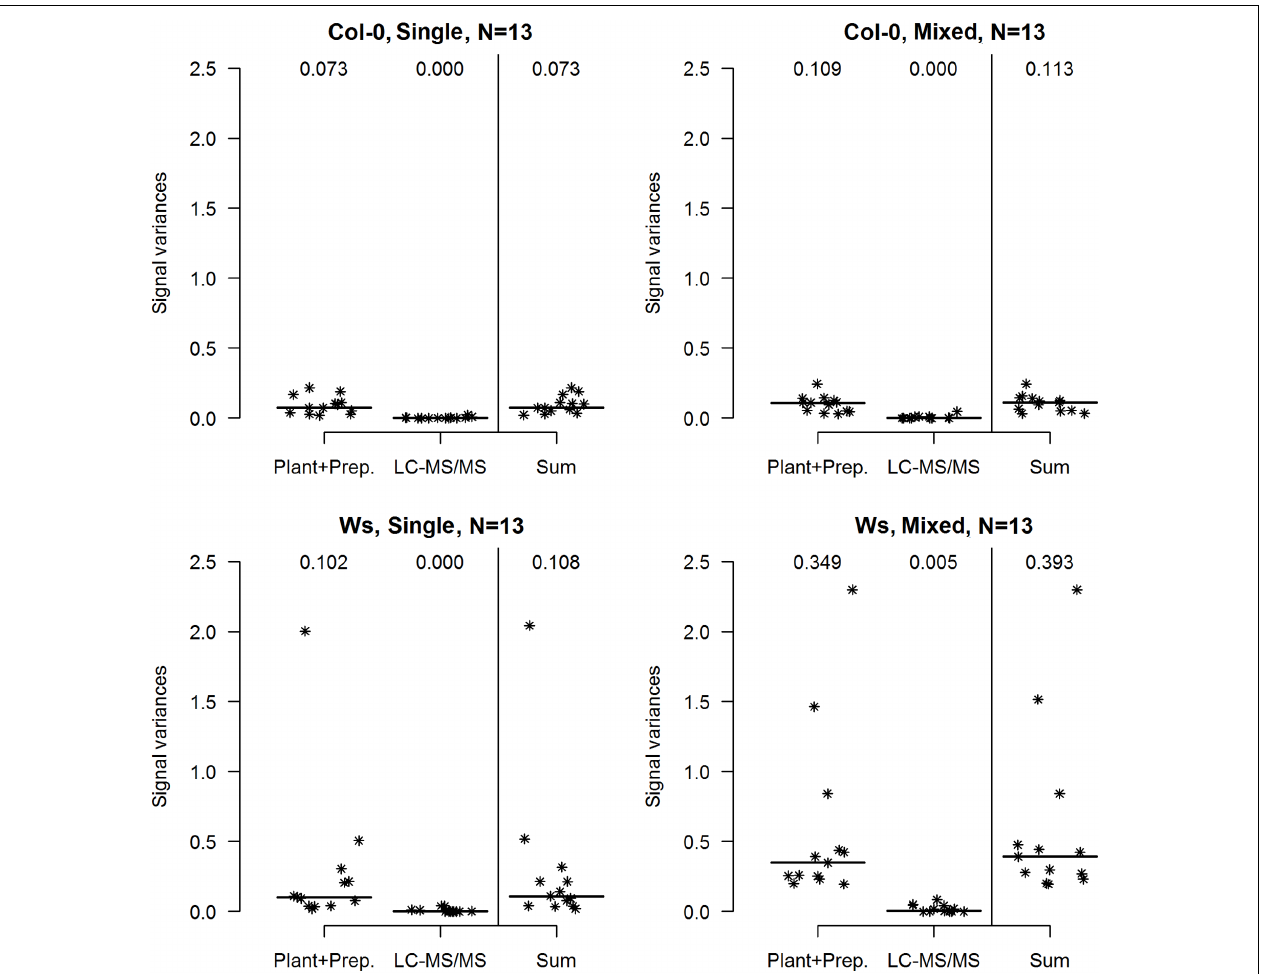
FIGURE 2 | Contributions of biological and technical components to the total variance of observed histone mark levels in A. thaliana Col-0 and Ws ecotypes grown from seeds collected from a single parent plant (Single) and a set of parent plants (Mixed). In each case, the total variance (Sum) of the abundance of selected individual H3 and H4 histone peptide forms ( N = 13) was decomposed into variance related to plant cultivation and sample preparation (biological, denoted Plant + Prep.) and variance related to measurement by the LC-MS/MS system (technical, denoted LC-MS/MS) by LMM. Medians are indicated by horizontal bars and